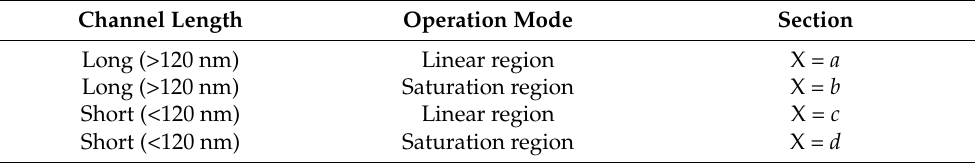
Table 1. Four separated sections are classified as long-short devices and linear-saturation regions. Channel Length Operation Mode Section Long (>120 nm) Linear